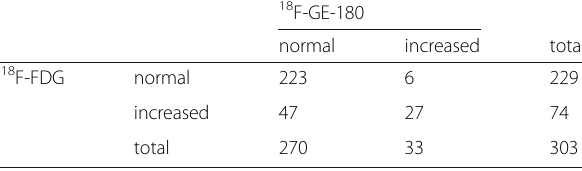
Table 5 Agreement between visual uptake scores of both